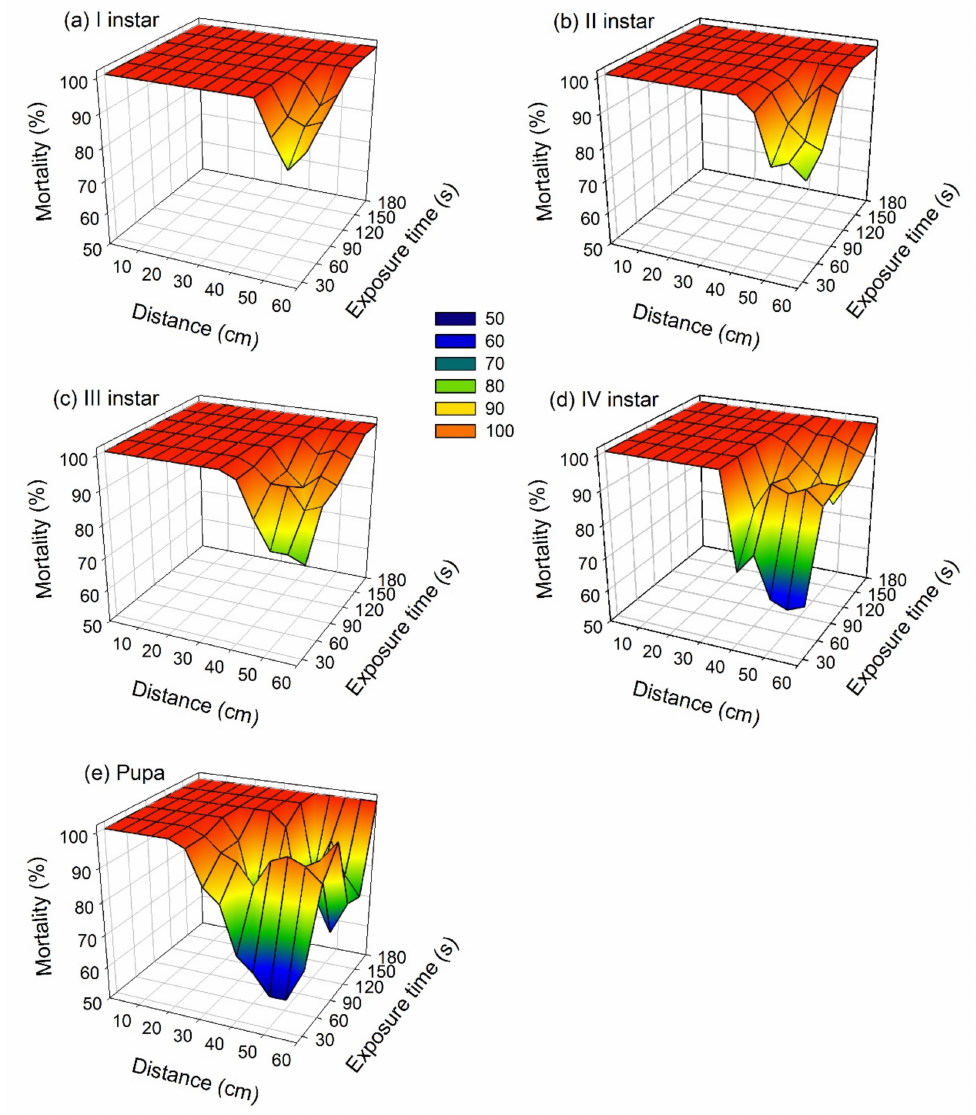
Figure 2. Mosquito mortality (%) achieved by the Larvasonic treatment over di ff erent conditions on Aedes aegypti young instars. Table 1. Results of two-way ANOVA testing the e ff ect of distance and exposure time on Aedes